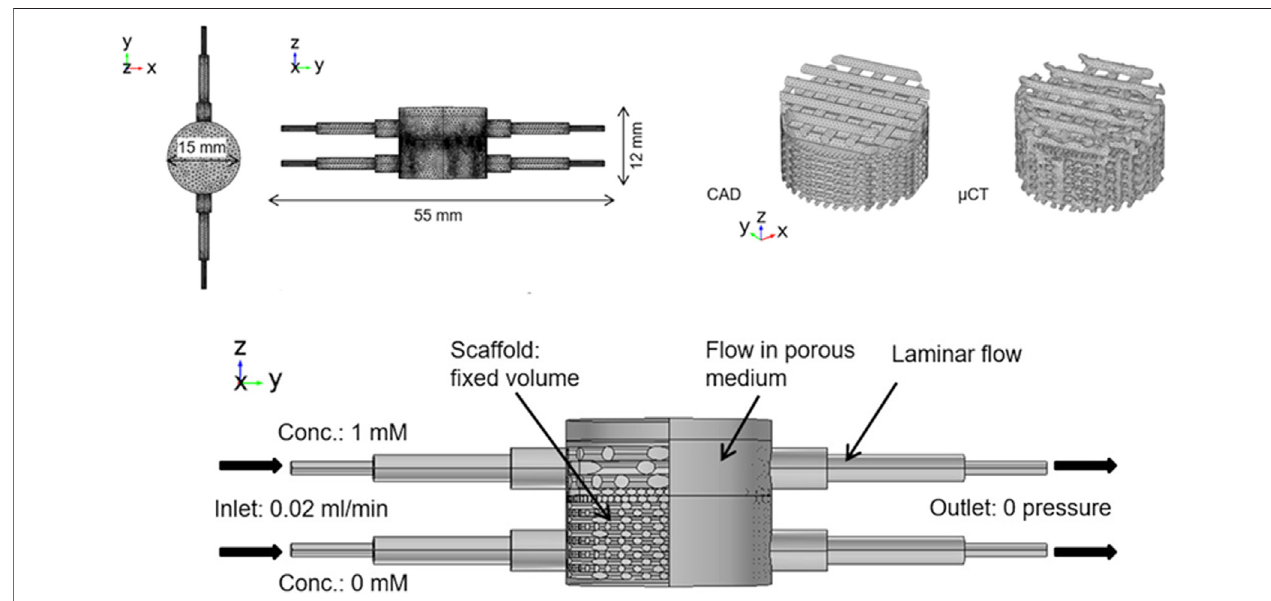
FIGURE 7 | A representative structure of bioreactors. Reproduced with permission (Xue et al., 2019). Copyright: © 2019 by the authors.